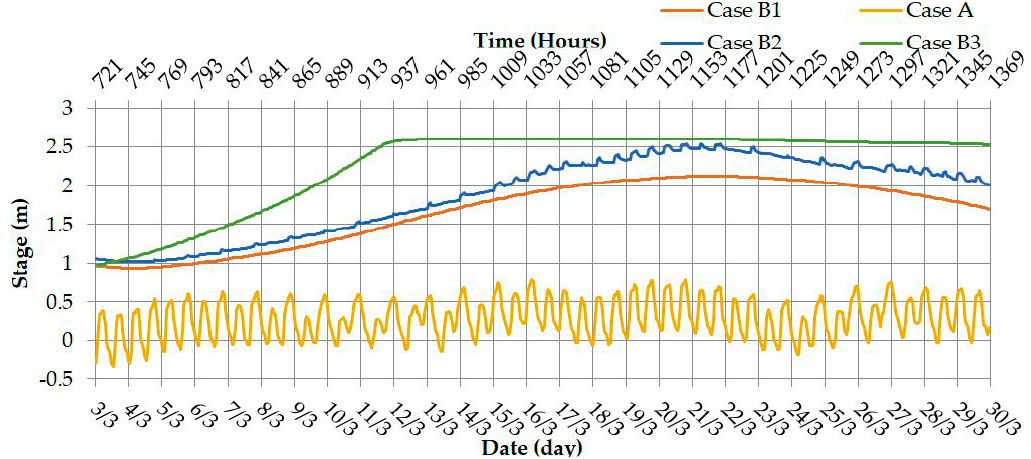
Figure 17. The stage in section no. 2.4 during the period of wave occurrence.